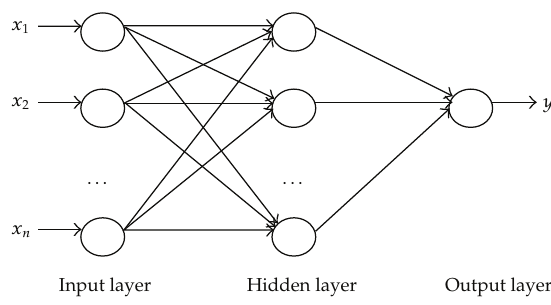
Figure 3: The plot of three-layer neural